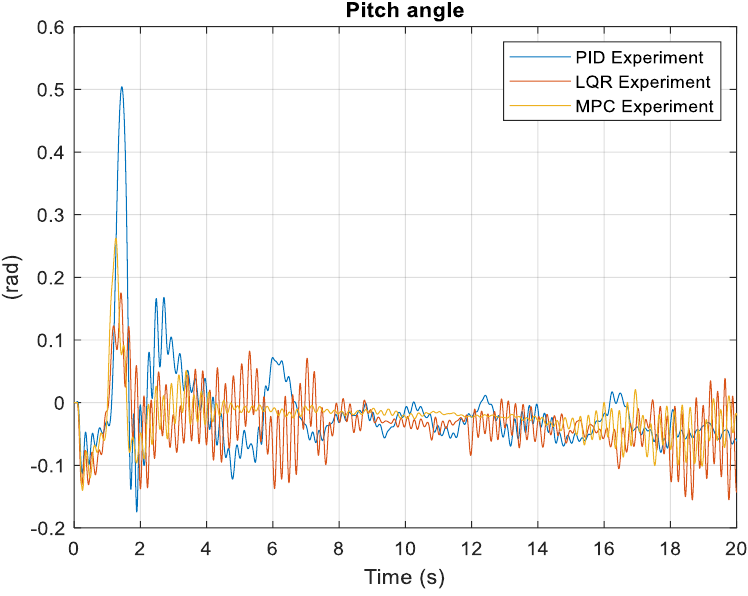
Figure 11. Performance of the controllers for pitch angle in real-time. This framework model takes operator command, raw sensor signals, and image data from the drone camera as inputs and calculates the four motor speed reference commands. The sensor signals are composed of three accelerometer signals, three gyroscope signals, optical flow data, ultrasound altitude signal, and pressure signal. Accelerometer, gyroscope, and pressure data are first calibrated by removing the constant bias terms detected during sensor initialization. Low pass filters are applied to the accelerometer data and yaw rate data. Then the complementary filter estimates the mini-drone orientation from the accelerometer, gyroscope signals, and yaw estimate from the optical flow driver. The aim of the complementary filter is to produce a converging estimate for the drone orientation through minimization of the error between accelerometer or optical flow and gyroscope integrated Euler angles. The altitude and vertical speed are then estimated from